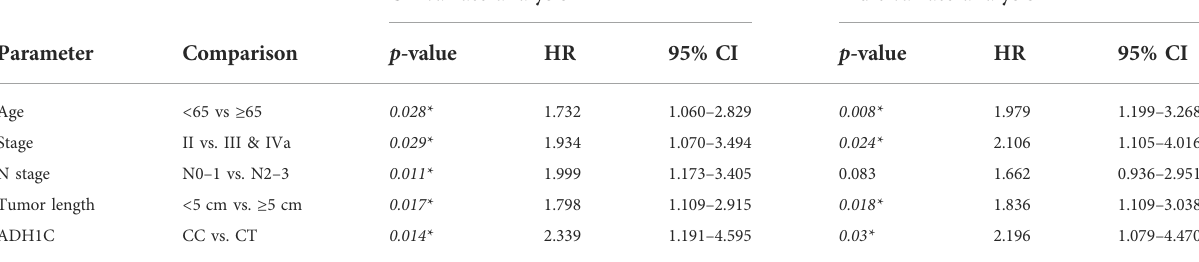
TABLE 3 Univariate analysis of clinical parameters and rs1789924 genotypes in predicting